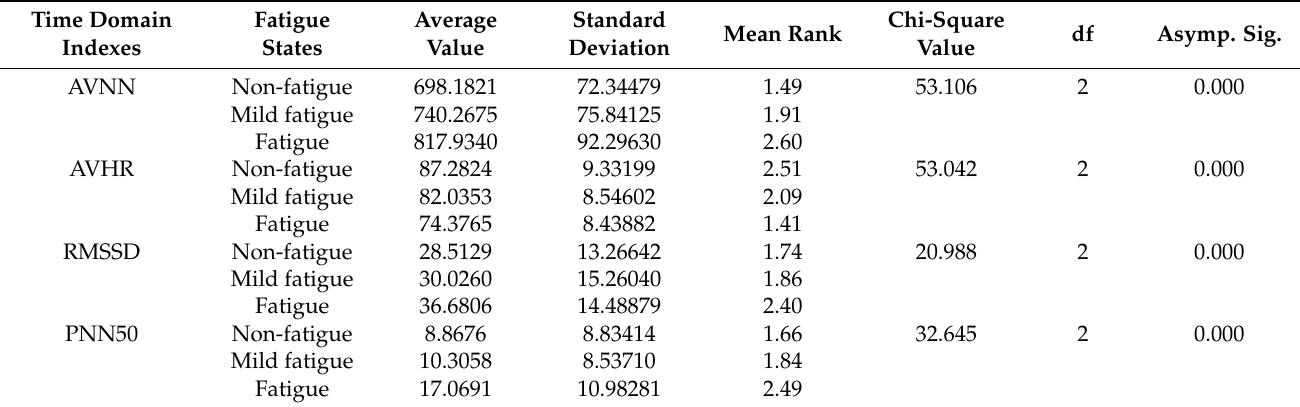
Table 7. Feature selection results of time domain indexes.